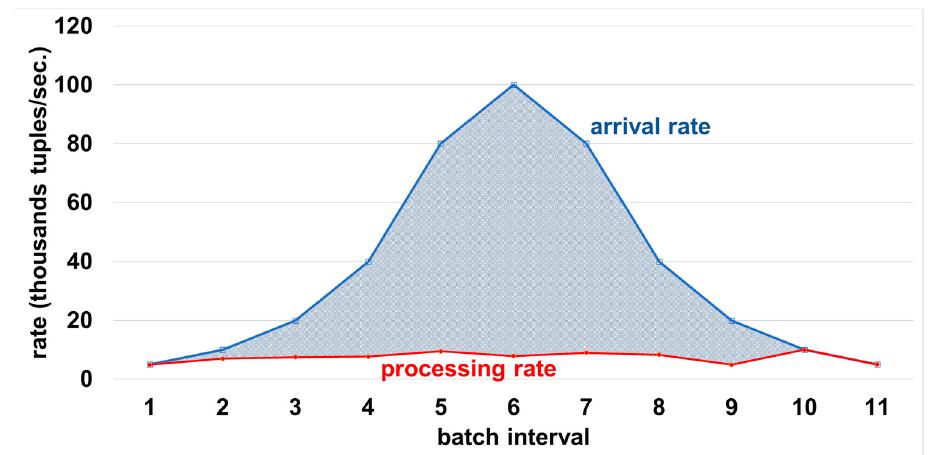
Figure 5. Binary tree ‐ based baseline [8] ability to catch ‐ up with various oscillations in data stream arrival rates. The patterned area between the two lines shows the dropped tuples. More tuples are dropped as compared to ApproxSSPS. The shaded area is significantly greater than the results from applying methods of ApproxSSPS, as shown in Figure 4. This means that a lower sampling fraction, which allows less data to continue its way to the approximation operator downstream the system. This leads to a lower accuracy as opposed to those results with the same load arriving to the ApproxSSPS system, as shown in Figure